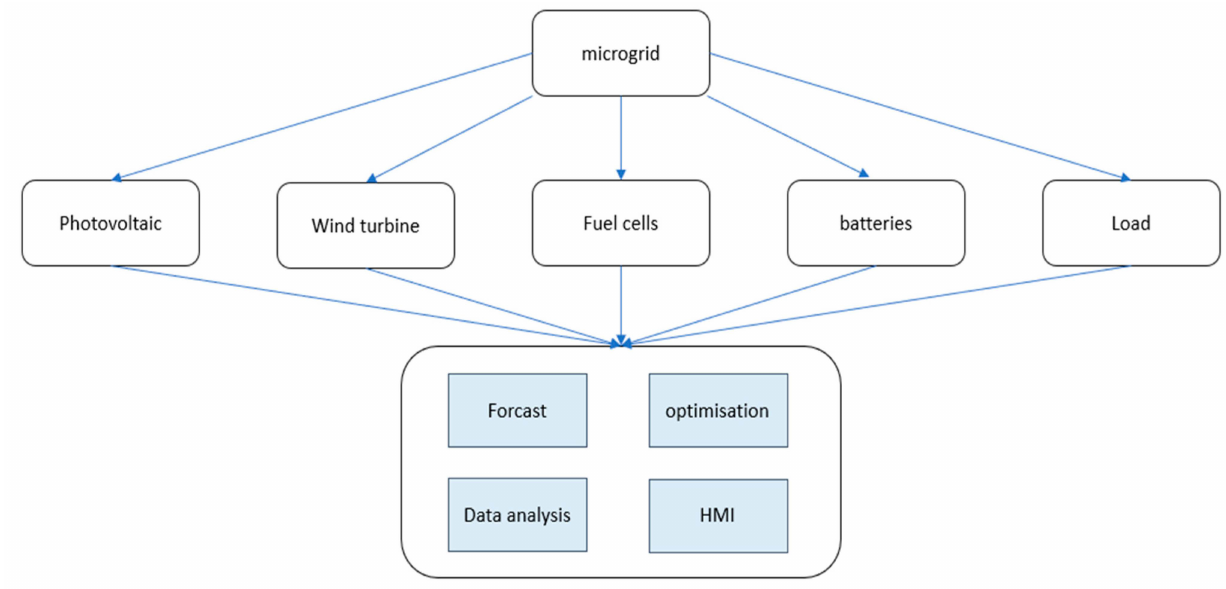
Figure 5. Management of a microgrid